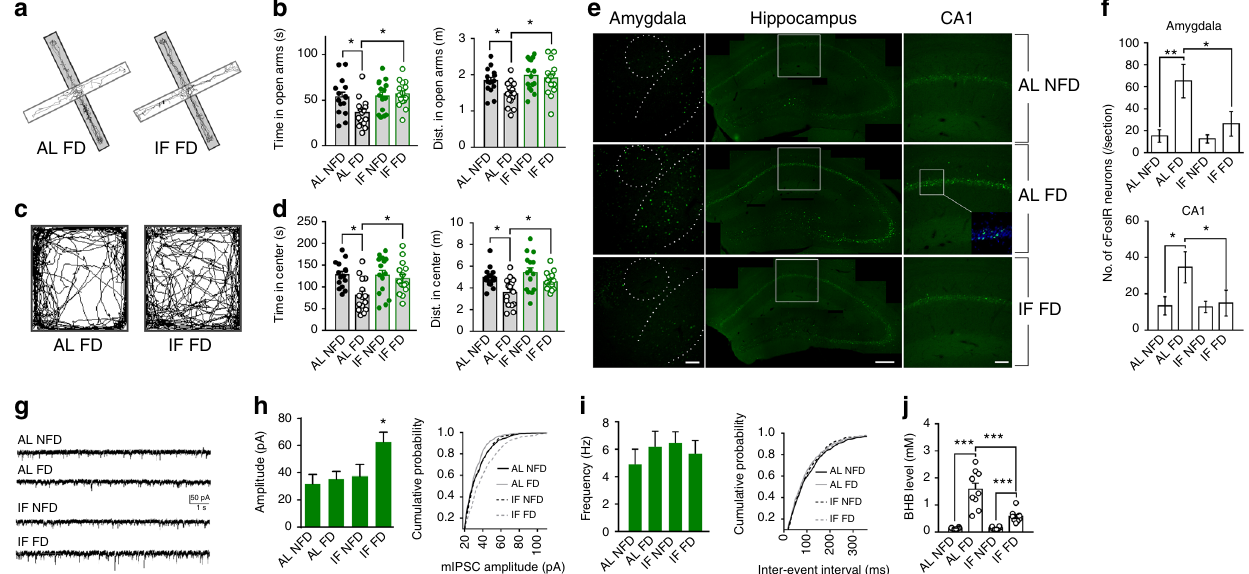
Fig. 1 Behavioral and neuronal network adaptations to IF involve enhanced GABAergic activity. a – d WT mice were maintained on either an ad libitum diet (AL) or a on IF for 1 month. Mice in each diet group were then randomly assigned to behavioral testing in the elevated plus maze and open fi eld after either a 24 h period of food deprivation (FD) or with no food deprivation (NFD). The images at the left show tracings of the walking paths of mice in the AL FD and IF FD groups in the elevated plus maze ( a , b ) and open fi eld ( c , d ). The numbers of mice in each group were: AL NFD, 13; AL FD, 15; IF NFD, 12; IF FD, 15. * P < 0.05. e Examples of images of c-Fos immunoreactivity in neurons in the amygdala, hippocampus and CA1 of mice in the indicated groups. The dashed lines in the images of the amygdala demarcate the boundaries of the central nucleus (upper circle) and the basolateral amygdala (lower curved lines). The white frames in the images of the hippocampus demarcate the location of the images of region CA1. f Numbers of c-Fos immunoreactive (cFosIR) neurons in the amygdala and hippocampal CA1 in mice in the four indicated groups (5 mice/group). * P < 0.05, ** P < 0.01. g Whole-cell recordings of miniature postsynaptic currents (mIPSCs) in CA1 neurons in hippocampal slices from mice in the four indicated groups. h Amplitudes of mIPSCs (left) and a plot of cumulative event probability as a function of mIPSC amplitude (right) in CA1 neurons of mice in the four different treatment groups (data are from 15 neurons in slices from 5 mice/group). * P < 0.05 compared to the values for each of the other three groups. i mIPSC frequency (left) and a plot of cumulative event probability as a function of mIPSC inter-event interval (right) in CA1 neurons of mice in the four different treatment groups (5 mice/group). j Serum β -hydroxybutyrate (BHB) concentrations in mice in the indicated groups. *** P < 0.001. All error bars are the SEM. All